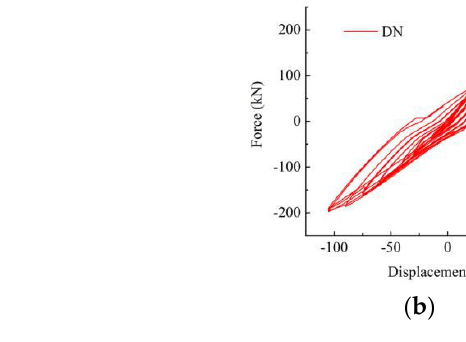
Figure 12. Hysteresis curves of specimens DC and DN. ( a ) Hysteresis curve of DC. ( b ) Hysteresis curve of DN.